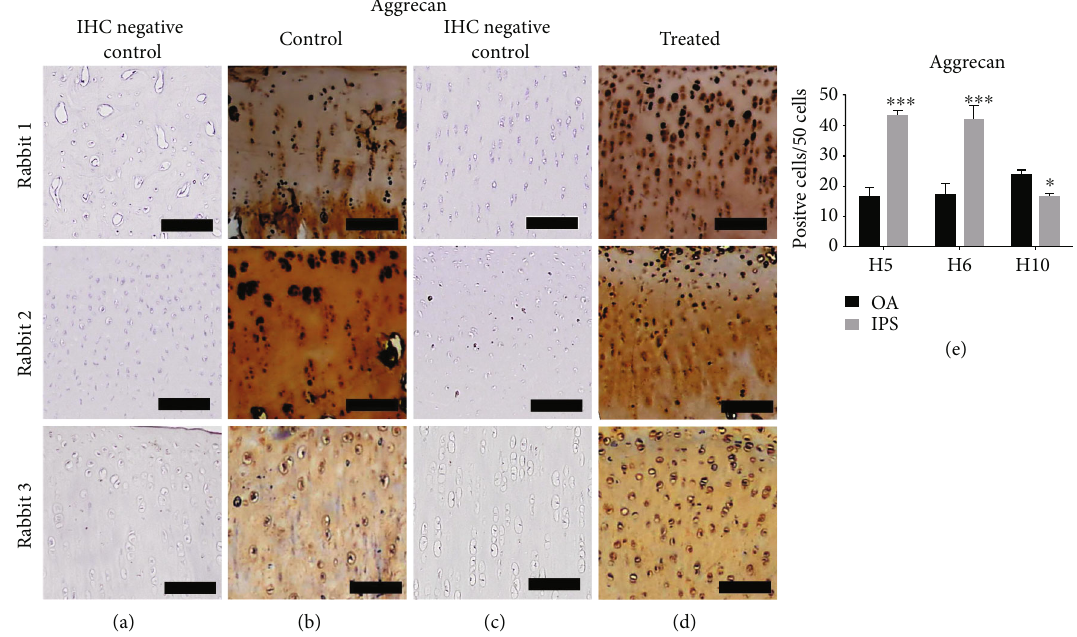
Figure 9: The immunohistochemistry (IHC) in iPSC – MSC-chondrocytes transplant cartilages ( n = 3 ). (a, b) The IHC of aggrecan in control cartilage with IHC-negative control (a) and staining cartilage (b). (c, d) IHC of aggrecan in treated cartilage with IHC-negative control (c) and staining cartilage (d). Scale bar = 100 μ m . (e) Quanti fi cation of aggrecan+ cells in 50 cells. More aggrecan+ cells/50 cells were noted in rabbit 1 and 2. ∗ p < 0 : 5 , ∗∗∗ p < 0 : 01 . Statistical analyses between both groups were calculated with Mann – Whitney U test.